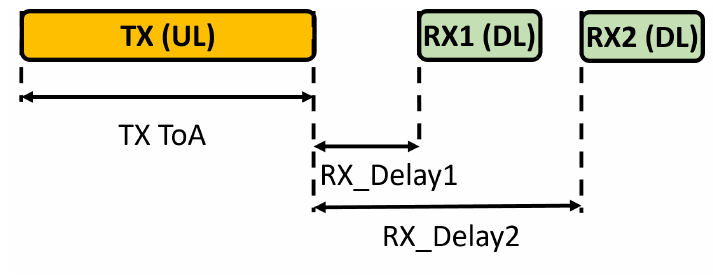
Figure 2. Receiving window timings for Class A